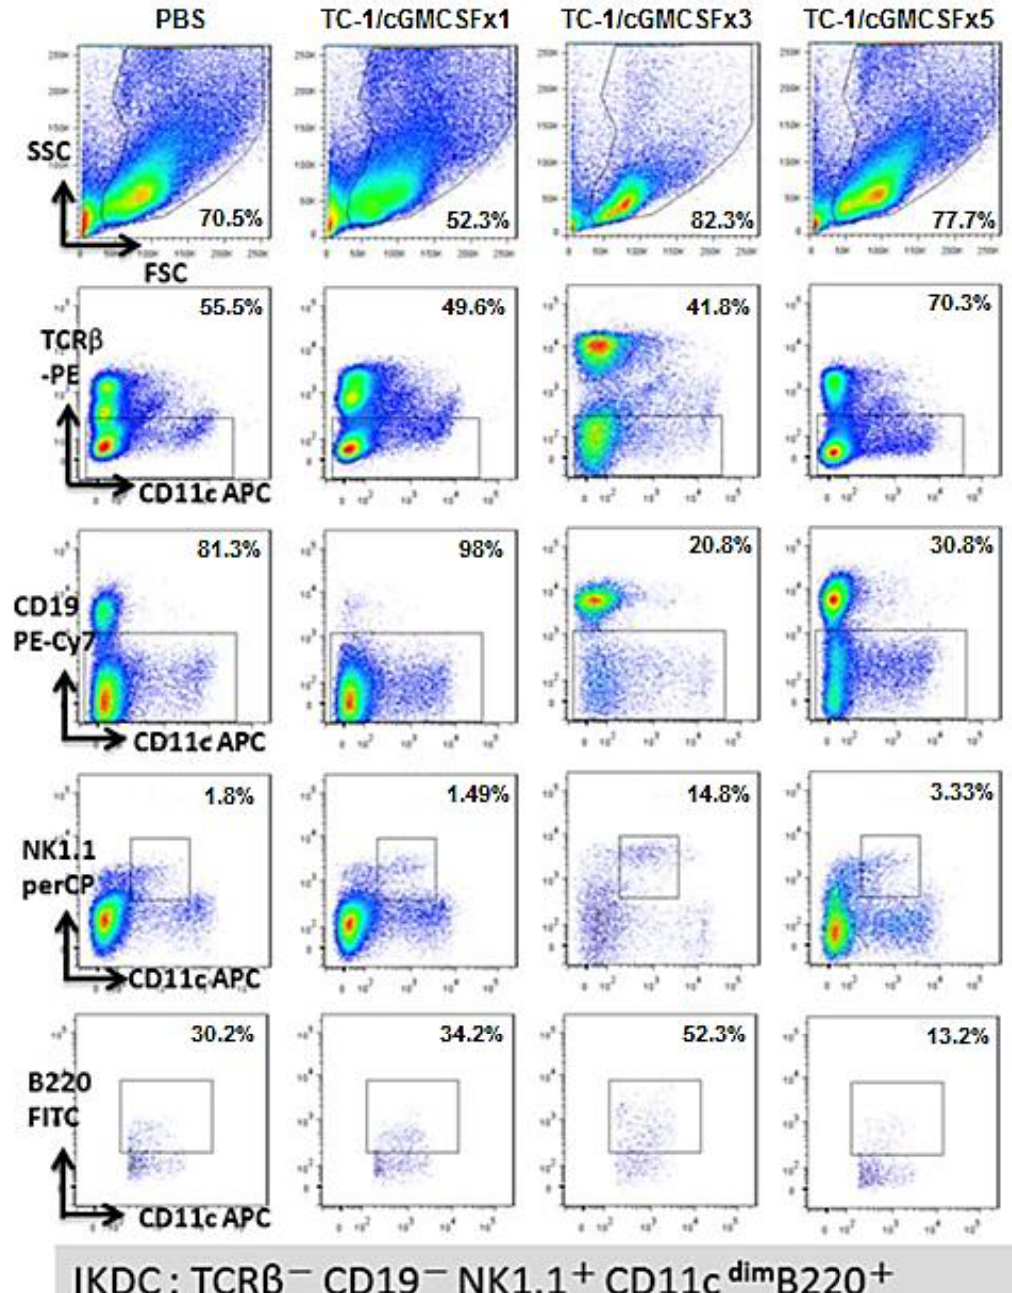
Figure 4. Vaccination three times with irradiated TC-1/cGM-CSF vaccine generates a higher percentage of interferon-producing killer dendritic cells (IKDCs) compared with vaccination five times. C57BL/6 mice were subcutaneously immunized with 1 × 10 6 irradiated TC-1/cGM-CSF cells in the dorsal flank. Seven days after the last immunization, cells were isolated from the mice’s spleens, and flow cytometry was performed to characterize IKDCs markers CD11c dim , B220 + , NK1.1 + , TCRβ − , and CD19.